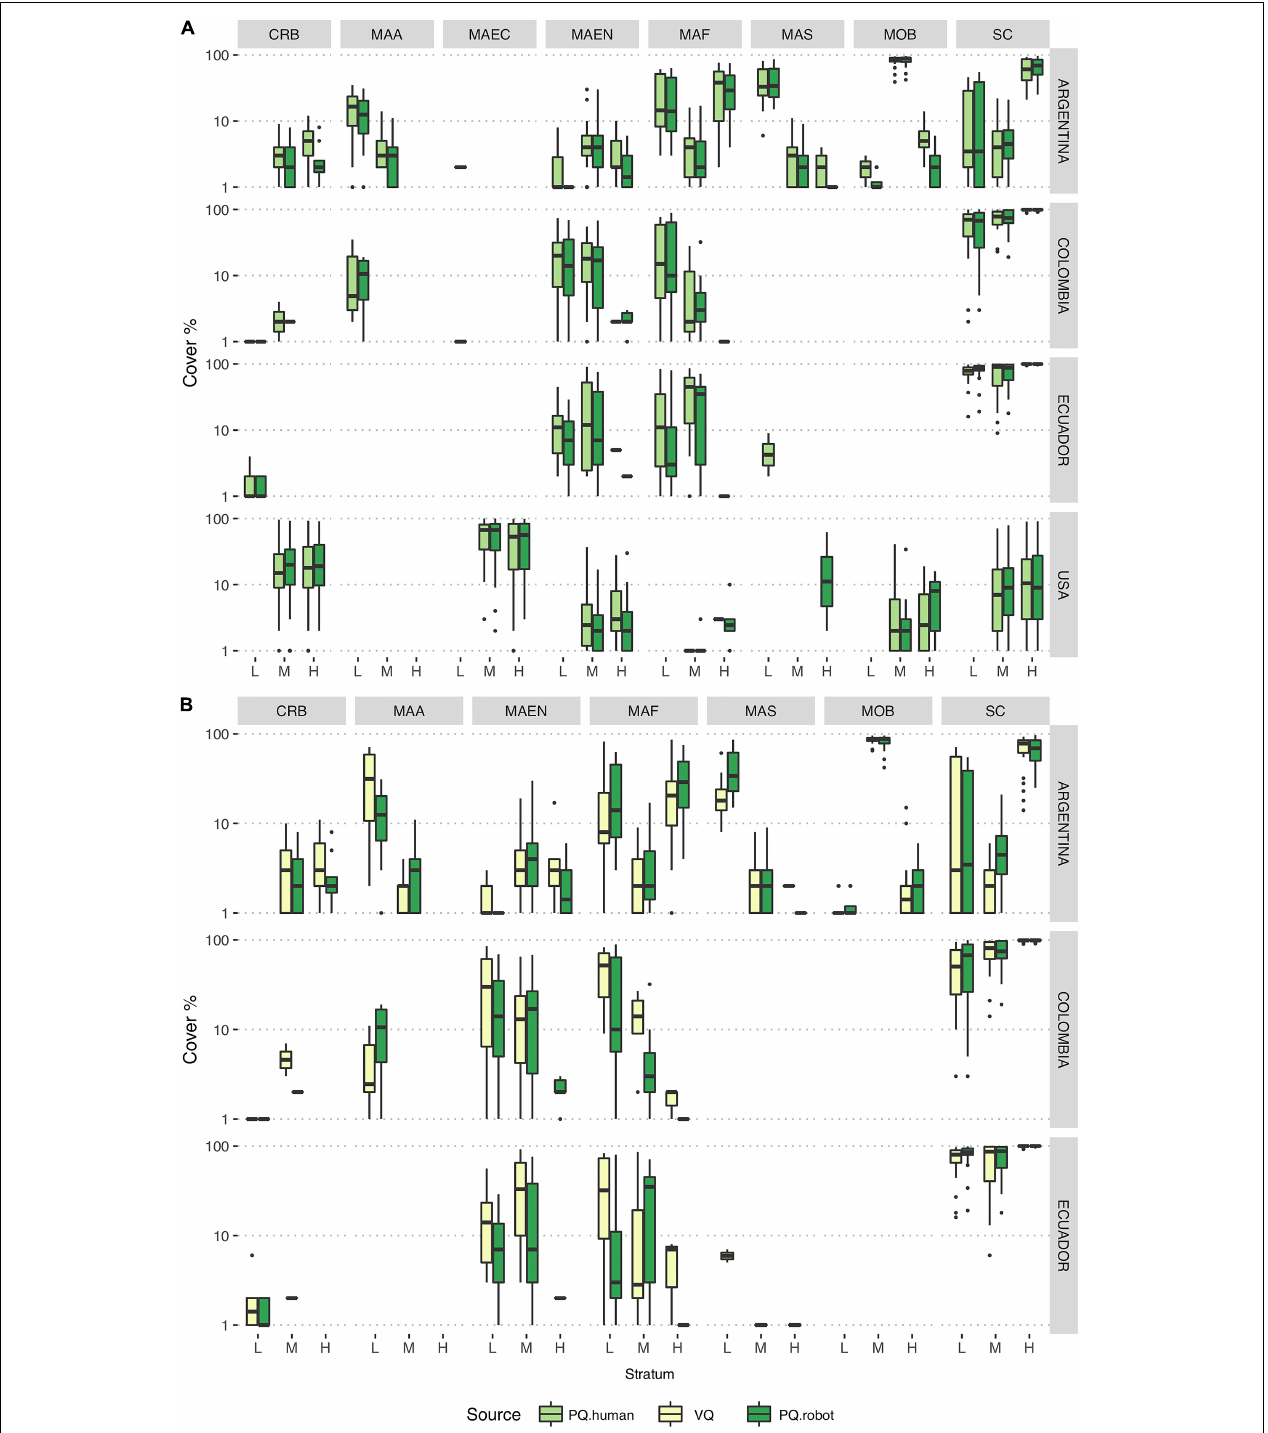
FIGURE 2 | Boxplots showing percentage cover estimates of most abundant CATAMI categories [CRB, Crustacea: Barnacles; MOB, Mollusks: Bivalves; SC, Substrate: Consolidated (hard); MAF, Macroalgae: Filamentous/filiform; MAEN, Macroalgae: Encrusting; MAA, Macroalgae: Articulated calcareous; MAS, Macroalgae: Sheet-like/membranous; MAEC, Macroalgae: Erect coarse branching] in each country and tidal strata as determined by different annotation methods. The horizontal bar within boxes represents the median, the lower and upper boxes represent the 25th and 75th percentiles, respectively, and the whiskers the 5th and 95th percentiles. Black dots represent outliers above the 95th percentile. (A) PQ.human vs. PQ.robot, (B) VQ vs. PQ.robot. L, low tide level; M, mid tide level; H, high tide level.